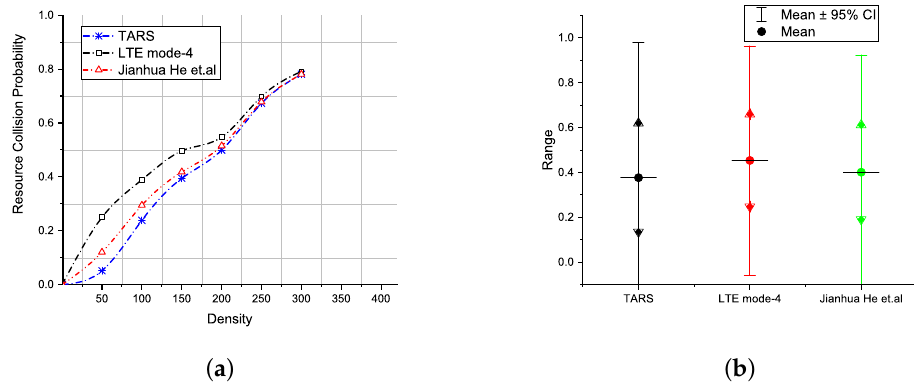
Figure 13. Resource collision probability; ( a ) with respect to density and, ( b ) a confidence interval of 95%.